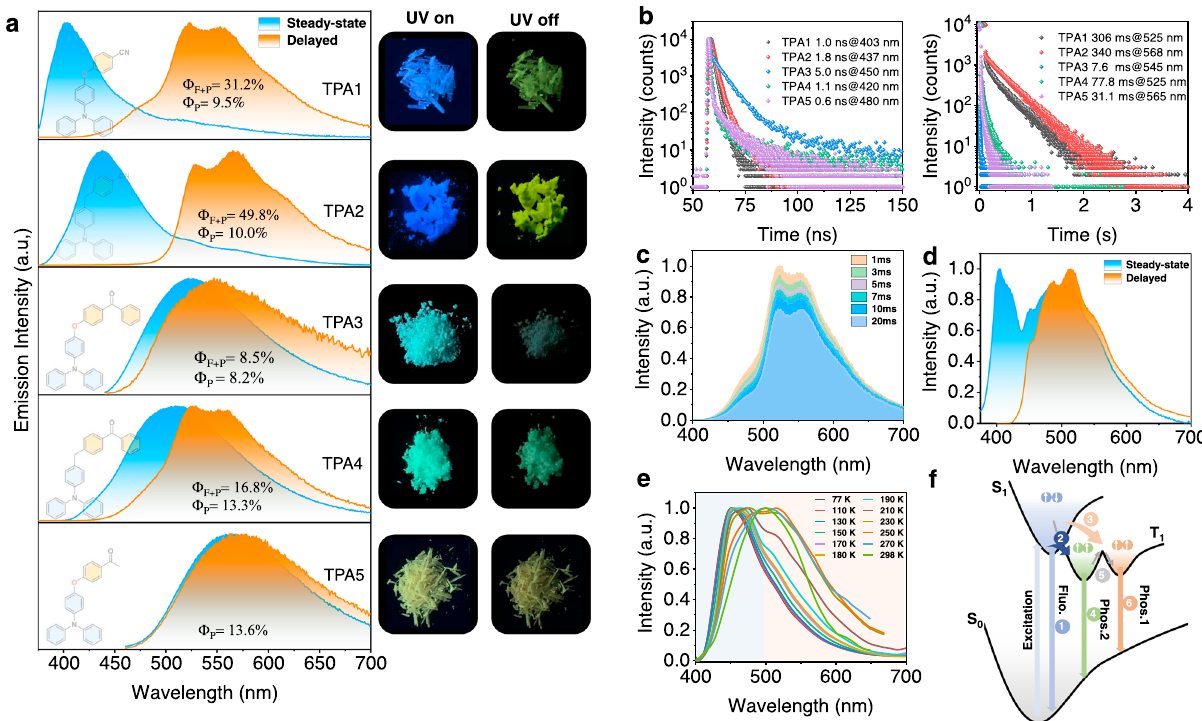
Fig. 4 Photophysical investigations for TPA1-5 molecular solids. a Normalized emission spectra of TPA1-5 in air at room temperature (excitation: 365 nm for TPA1, TPA2, and TPA4; 430 nm for TPA3; and 450 nm for TPA5) and corresponding photos showing TPA1-5 excited by 365-nm UV light. b Time- resolved decay pro fi les of TPA1-5 in air at room temperature (right: fl uorescence; left: RTP). c Time-resolved emission spectra of TPA1. d Normalized emission spectra of TPA1 at 77 K. e Normalized phosphorescence emission spectra of TPA1 dissolved in PMMA fi lm (excitation: 375 nm; concentration: 3%, w/w) at different temperatures. f Schematic illustration of the ternary emission process; process 1: fl uorescence; process 2: intersystem crossing at 77 and 298 K; process 3: favored intersystem crossing at 298 K; process 4 and 6: phosphorescence; and process 5: thermally activated conformation